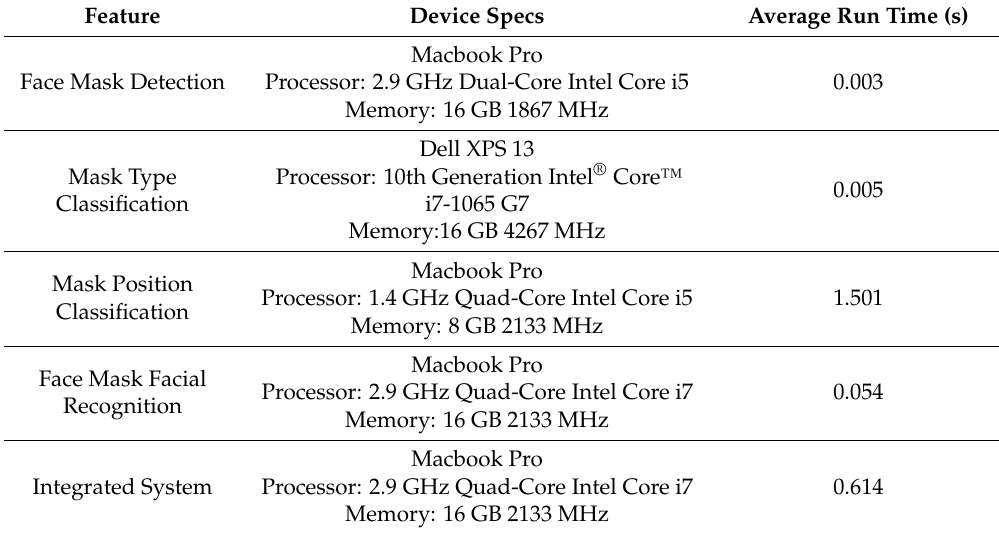
Table 5. Run-Time Performance